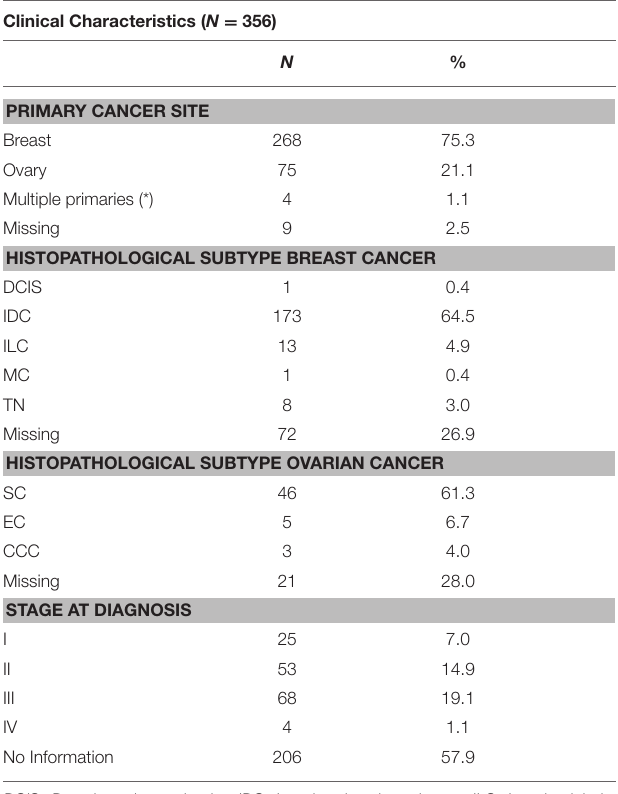
TABLE 2 | Clinical characteristics of 356 cancer patients recruited in the first phase of the LACAM study. Clinical Characteristics ( N =